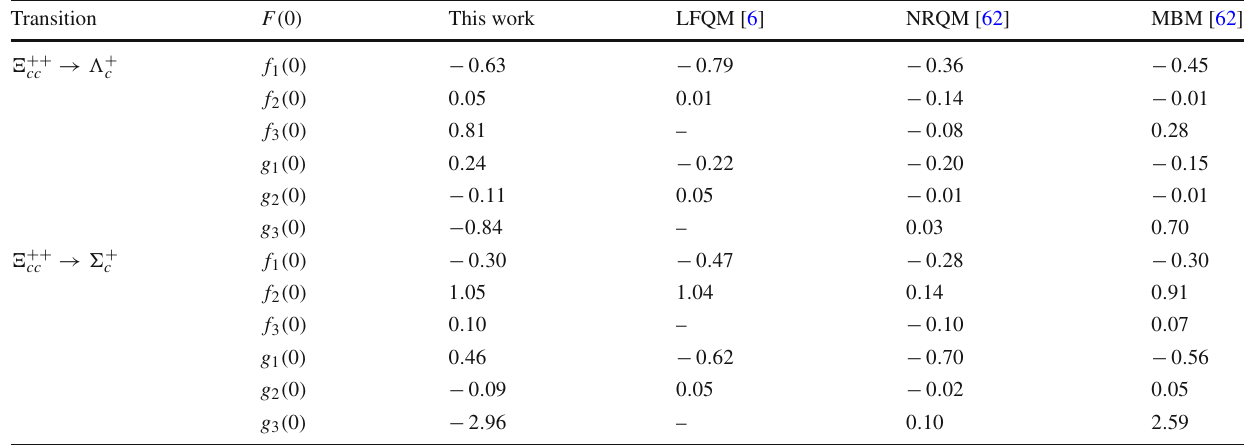
Table 12 Comparison with the results of the light-front quark model (LFQM) [6], the nonrelativistic quark model (NRQM) and the MIT bag model (MBM) [62] for the form factors of (cid:2) ++ cc → (cid:3) + c and (cid:2) ++